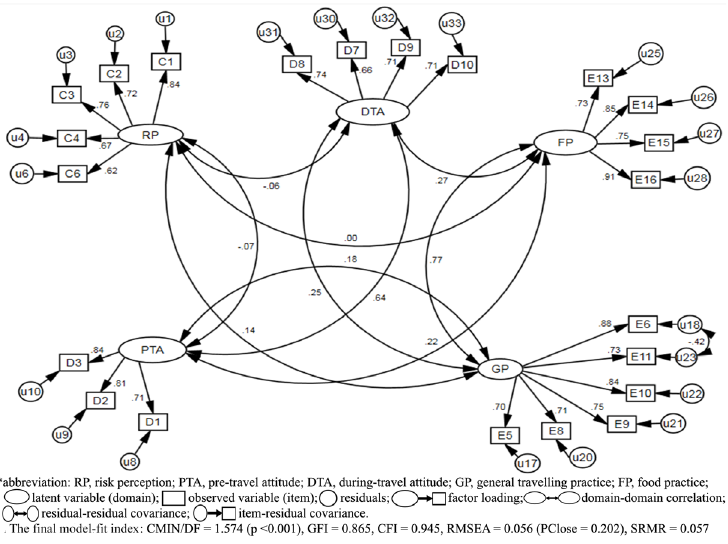
Figure 1. Path analysis of the confirmatory factor analysis (CFA) showing standardized estimates of the correlations (figures on the arrows) between the 5 domains (ellipse), the 22 items (rectangle), and their respective residuals